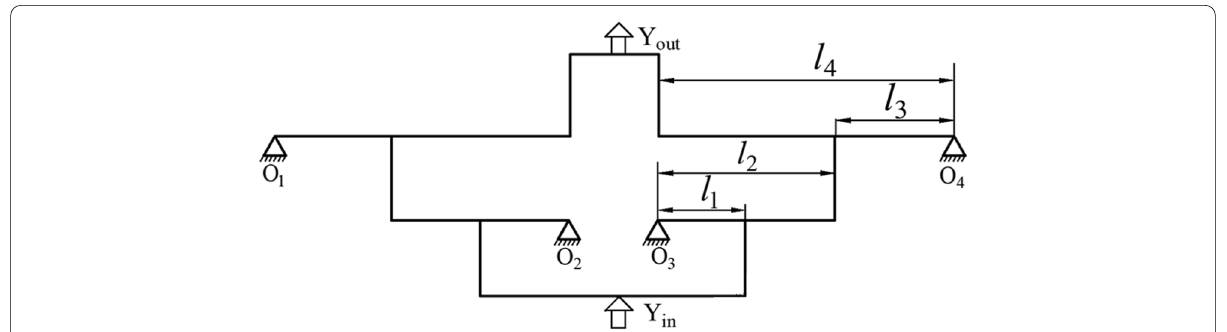
Fig. 2 Two-stage amplification principle diagram of micro-drive